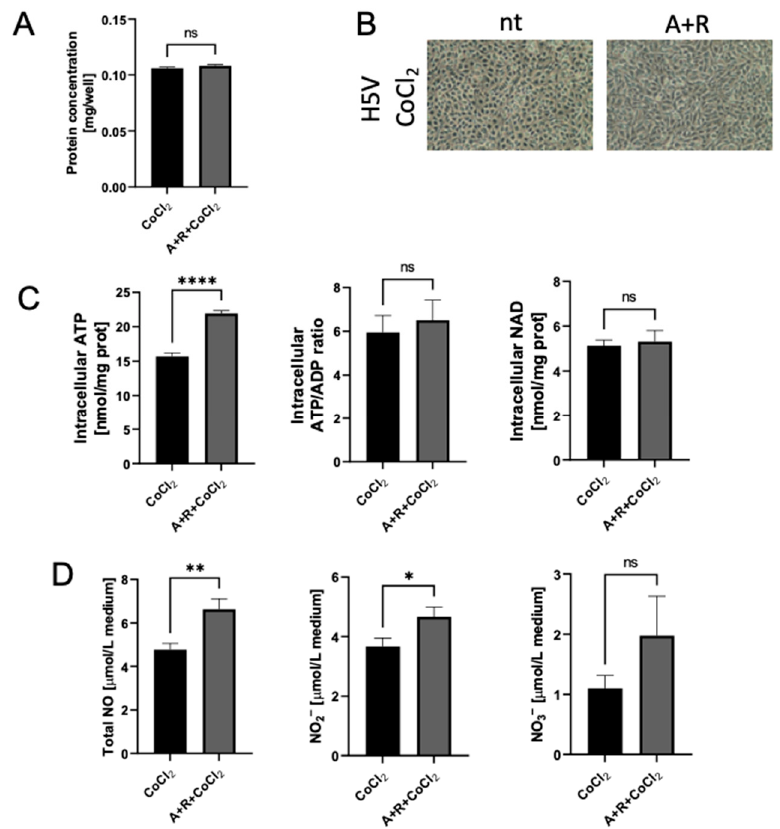
Figure 3. Adenine and ribose supplementation enhanced intracellular nucleotide pool and endothelial function in CoCl 2 -treated H5V endothelial cells. ( A ). Total cell protein, ( B ). Representative H5V cell images after CoCl 2 -mimicked hypoxia in the presence (A + R) and absence (nt) of 100 µ M adenine and 2.5 µ M ribose; ( C ). Intracellular nucleotide concentration after A + R treatment during hypoxia conditions. ( D ) The concentration of total NO, NO 2– and NO 3– in the cell culture media after adenine and ribose treatment (A + R) after 24 h of CoCl 2 treatment. Results are shown as mean ± SEM; n = 6; * p <0.05; ** p < 0.01; **** p < 0.0001; ns = not significant.